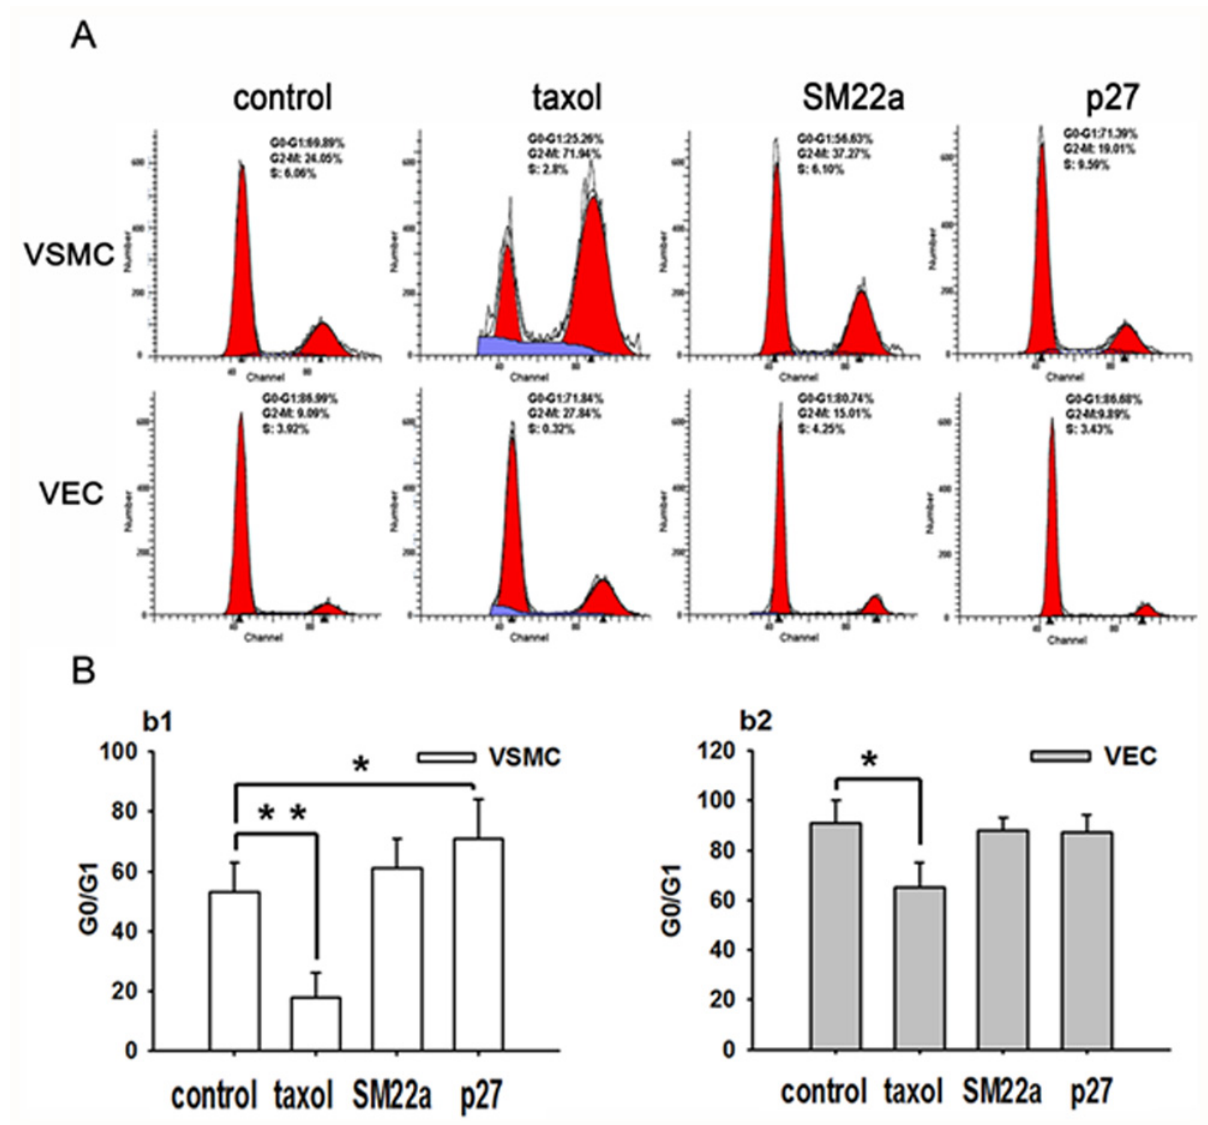
Fig 3. G0/G1 arrest in VSMCs (Lenti-SM22alpha-p27 group compared with paclitaxel group) in vitro. A. FACS data for VSMCs and VECs (control, taxol, SM22a, and p27 groups). B. G0/G1 distribution in VSMCs (b1) and VECs (b2). * (p < 0.05, taxol vs. control). ** (p < 0.05, p27 vs. control). Error bars represent the mean ± S.E. (n =